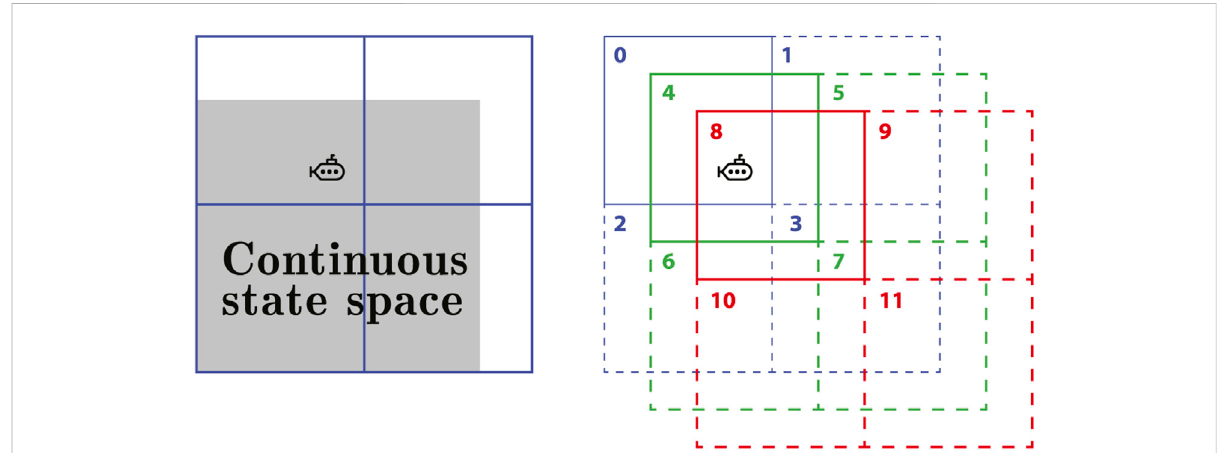
FIGURE 2 An example of tile coding representation of a continuous 2D state space. The agent is a point in the state space to be represented by the active tilesofthethree tilings.Active tiles aredescribed bysolidlinesand have avalueof1.Inactive tiles aredescribedbydashedlines andhave avalueof0. Therefore, the feature vector is x ( s ) = [1, 0, 0, 0, 1, 0, 0, 0, 1, 0, 0,